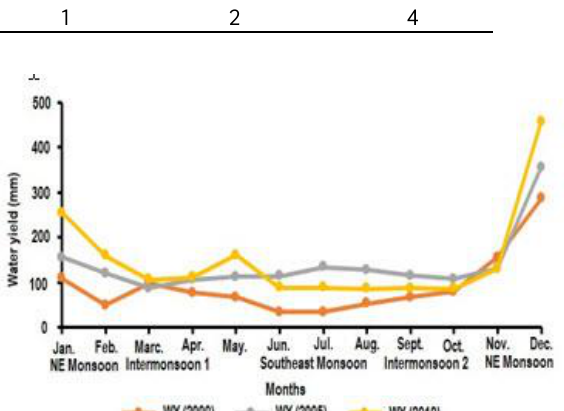
Figure. 5: Analysis of water